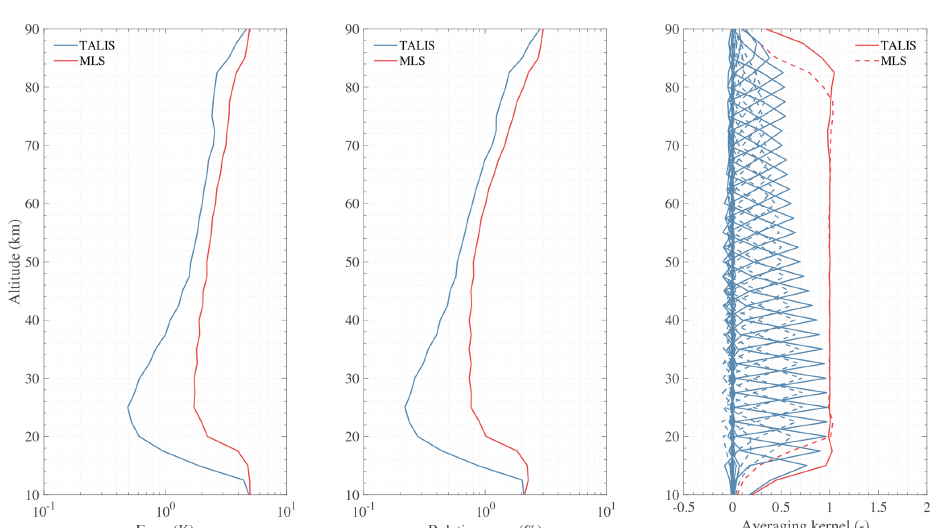
Figure 9. Temperature product comparison between the TALIS FFT spectrometer and the MLS “Standard” spectrometer using the 118.75GHz line. All other factors are